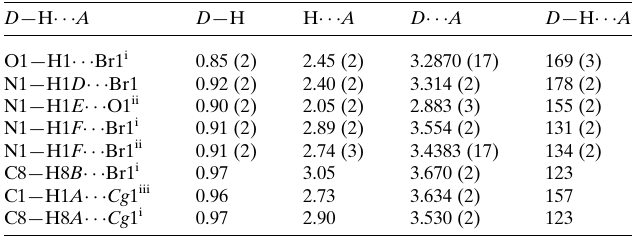
Table 1 Hydrogen-bond geometry (A˚ , (cid:5) ). Cg 1 is the centroid of the C2–C7 benzene ring.